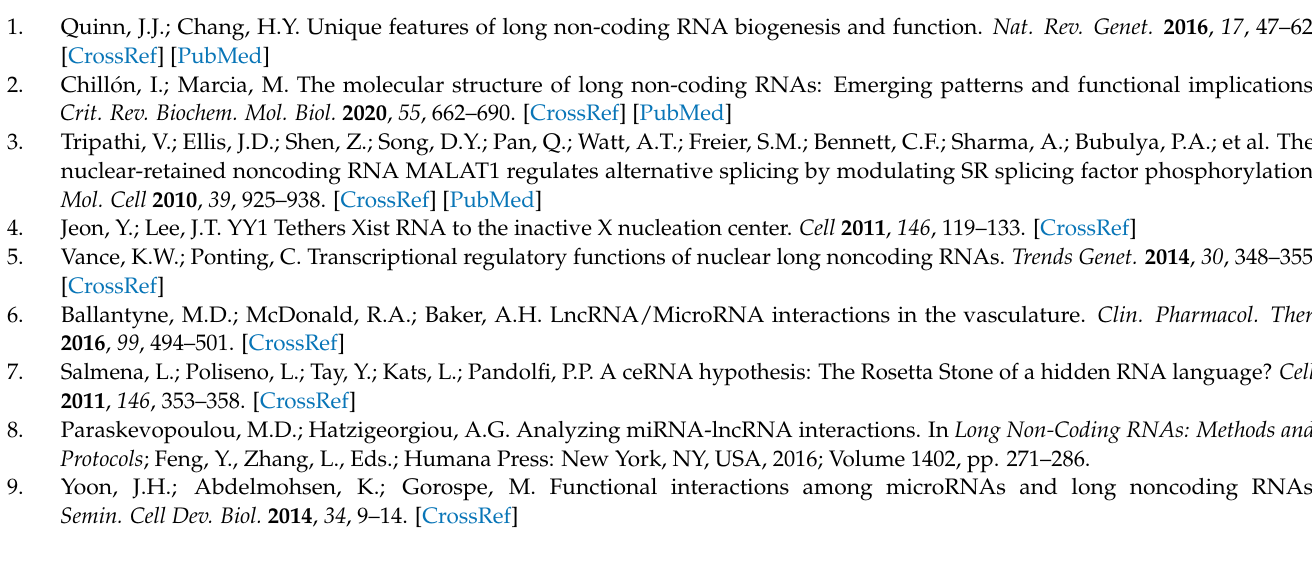
Figure 2 showing K562 DMS-Seq structural changes on the MALAT1 secondary structural model. Supplemental Figure S2: Poster-size image (approximately 19 in. by 31 in.) of Figure 6 showing HeLa PARIS data on the MALAT1 secondary structural model. Supplemental Table S1: Sequence markup and analysis of K562-MALAT1 structural changes on various structure-dependent functions. Sup- plemental Table S2: Analysis of HeLa-MALAT1 structural changes on various structure-dependent